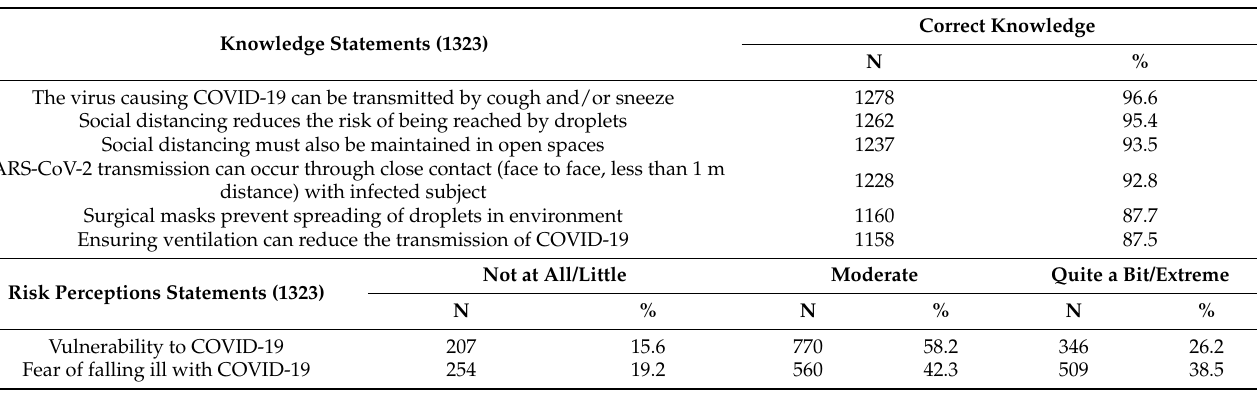
Table 1. Knowledge and risk perceptions about COVID-19.